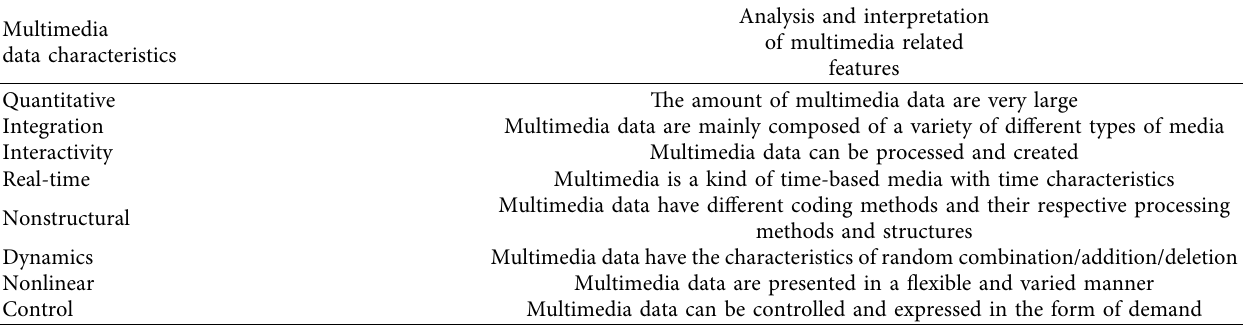
Figure 8: Relevant proportion of multimedia data types. Table 4: Correlation analysis and explanation of multimedia data characteristics.